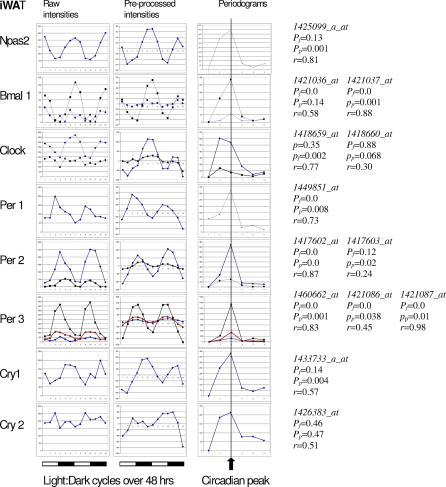
Expression Profiles and Periodicity Analysis of Basic Circadian Rhythm Genes in iWATThe first column plots are raw expression values as reported by the Affymetrix MAS5 algorithm. The second column plots show the same data after preprocessing (central value adjustment, polynomial smoothing, and trimmed mean subtraction). The third column presents the periodograms resulting from DFT analysis. Highlighted is a single peak corresponding to the circadian rhythm (two complete cycles in 48 h). For each probeset, representing a particular gene, the results of Fisher's g-test (pf), permutation test (pp), and autocorrelation (r) with circadian lag are listed to the right.